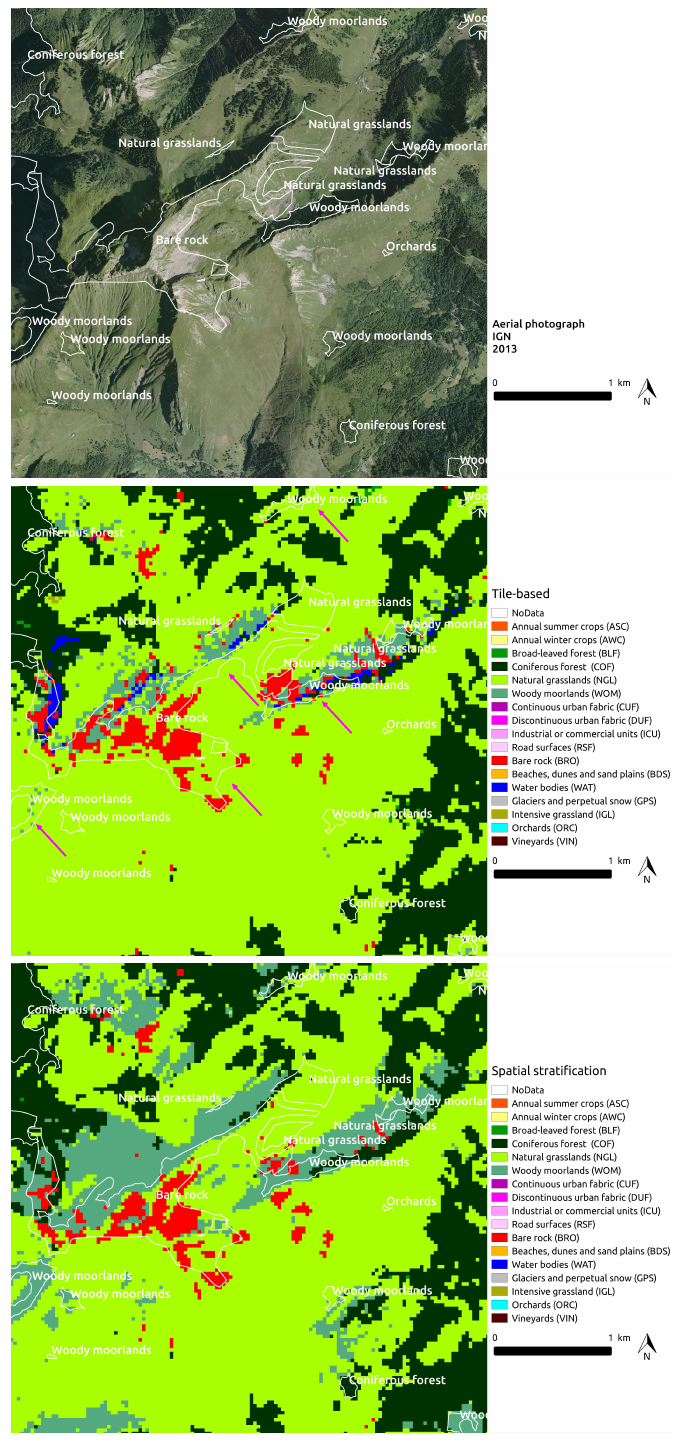
Figure 19. Analysis of errors on a mountain area. Errors are marked with magenta